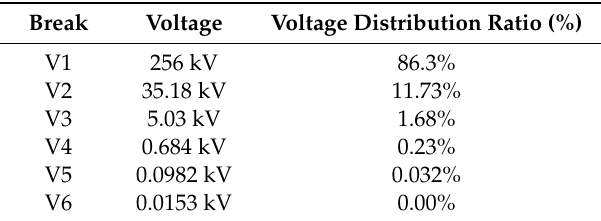
Table 3. Voltage sharing of each break.